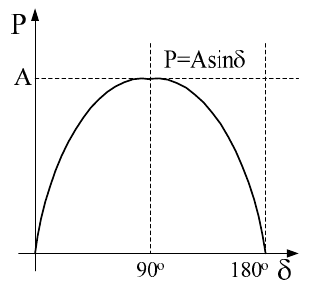
Figure 5. Relationship between the generator angle δ and the active power P.